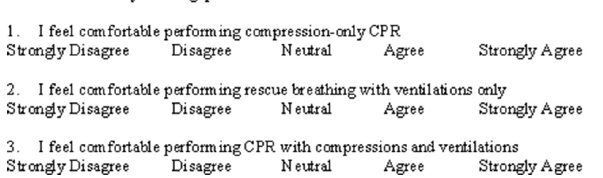
Figure 1. Pre-assessment Basic Life Support survey of medical students and physician assistant